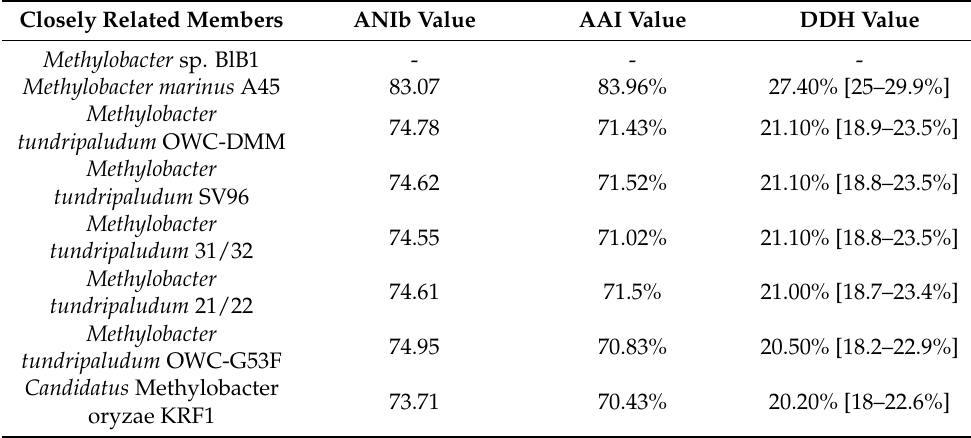
Table 1. ANIb, AAI, and DDH calculation of strain BlB1 with its closely related members. Closely Related